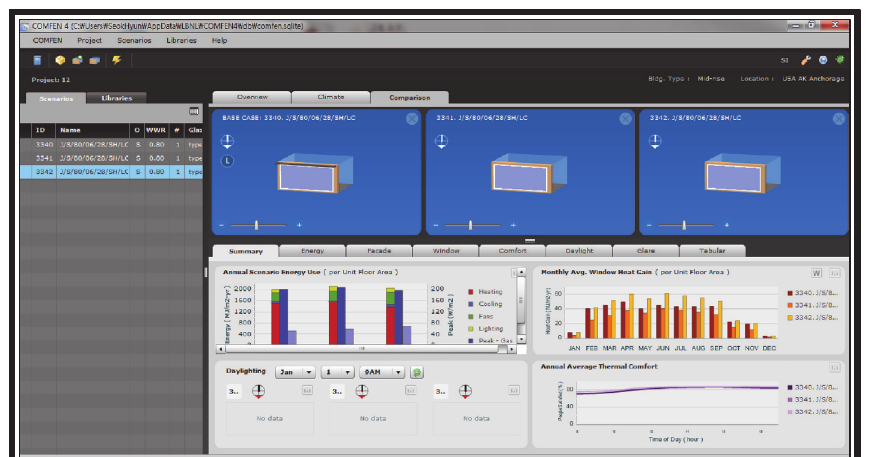
Figure 2: COMFEN.